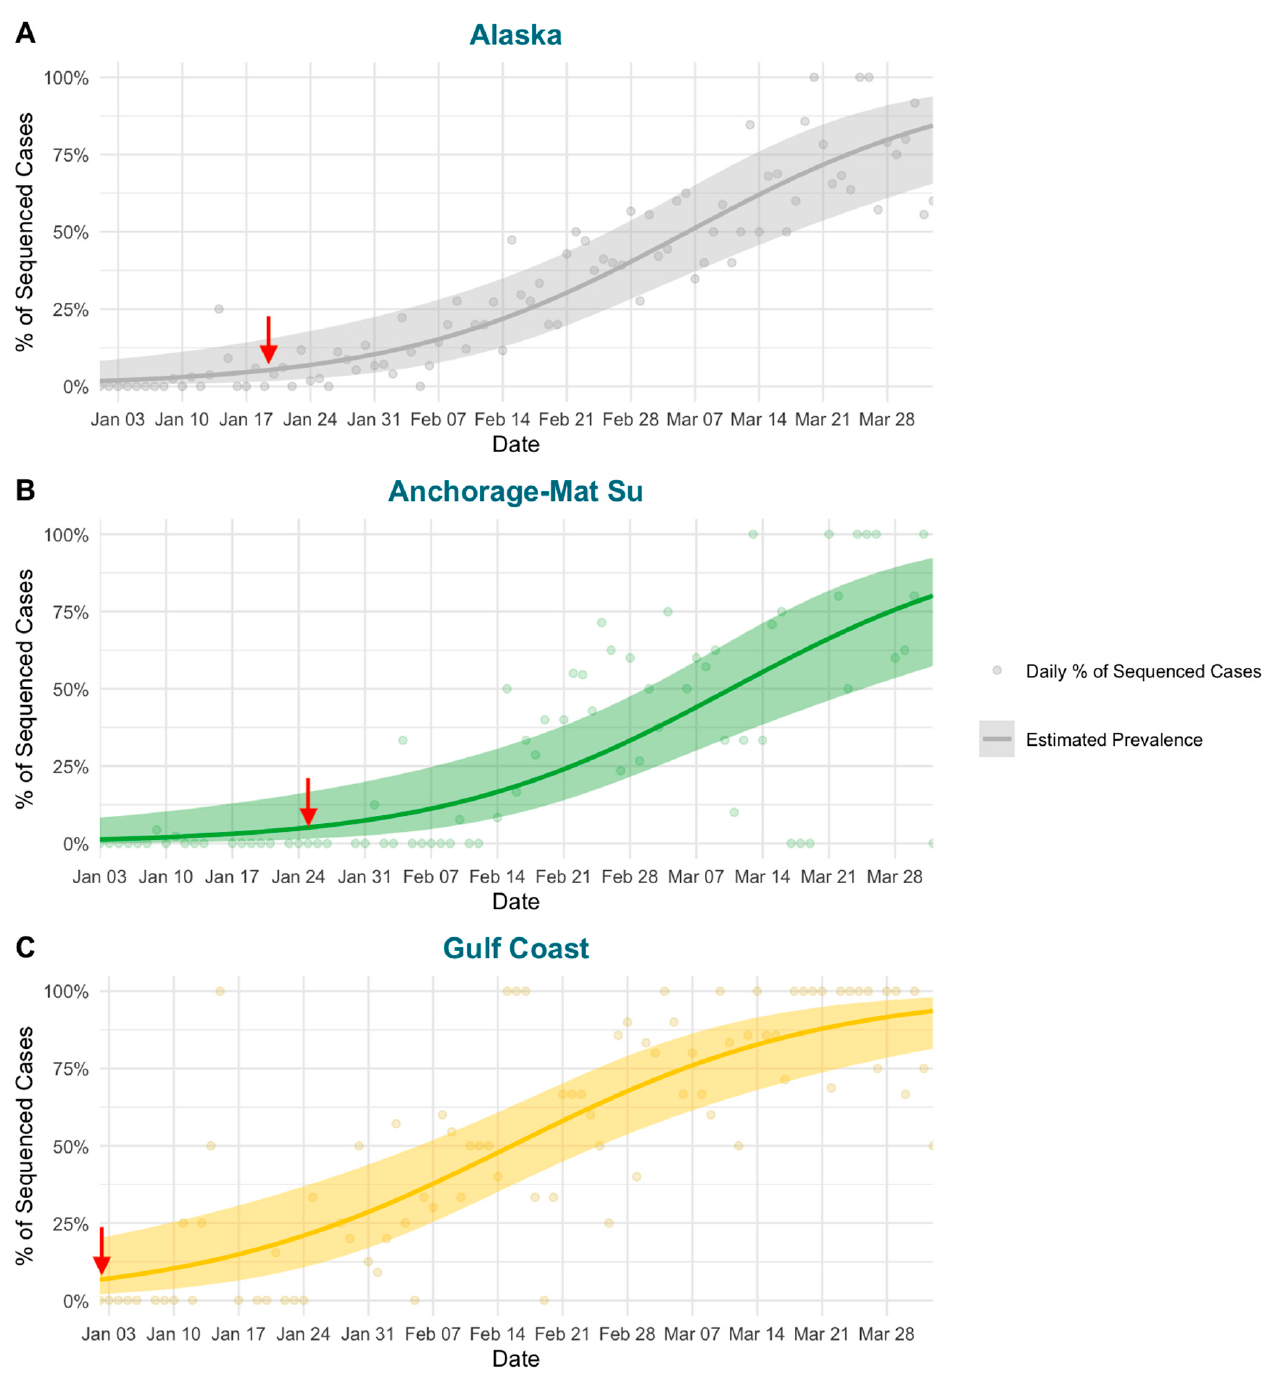
Figure 4. Logistic regression (line = regression; shaded region = standard error) estimating the prevalence of BA.2.3 over time in ( A ) Alaska and the two economic regions of Alaska with a deep enough coverage of cases including ( B ) the Anchorage-Mat Su and ( C ) Gulf Coast. Points represent the daily percent of cases assigned to BA.2.3 used to calculate the regression. The red arrow highlights when the regression estimated BA.2.3 was at greater than 5%